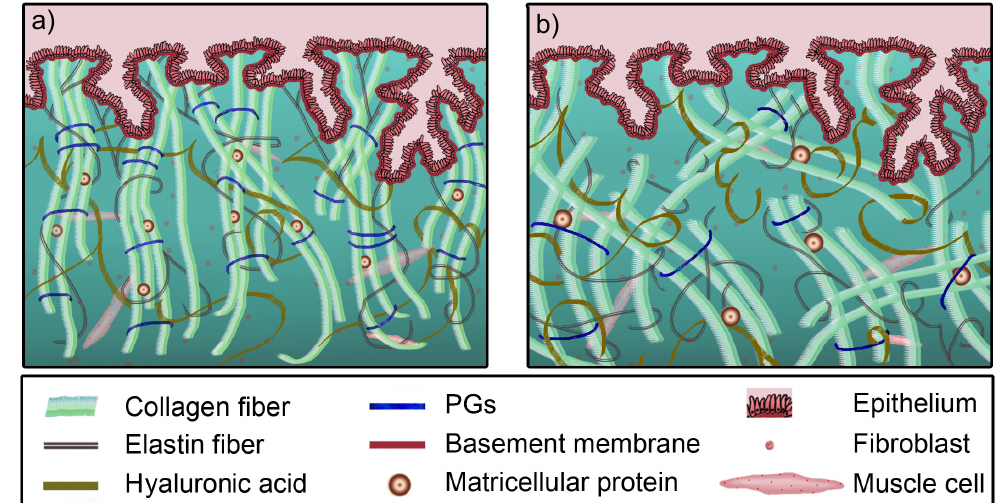
Figure 1. Histological illustration of the ECM remodeling as an example of cervical tissue during pregnancy. ( a ) The structure of the constituents in non-pregnant women. ( b ) The morphological evolution near the end of pregnancy. Quantitatively, there are increases in active cell and water contents, and crimping; and the diameter of collagen fibers increases, while PGs show a cyclic behavior. The legend at the bottom describes the symbol for each constituent; PGs: